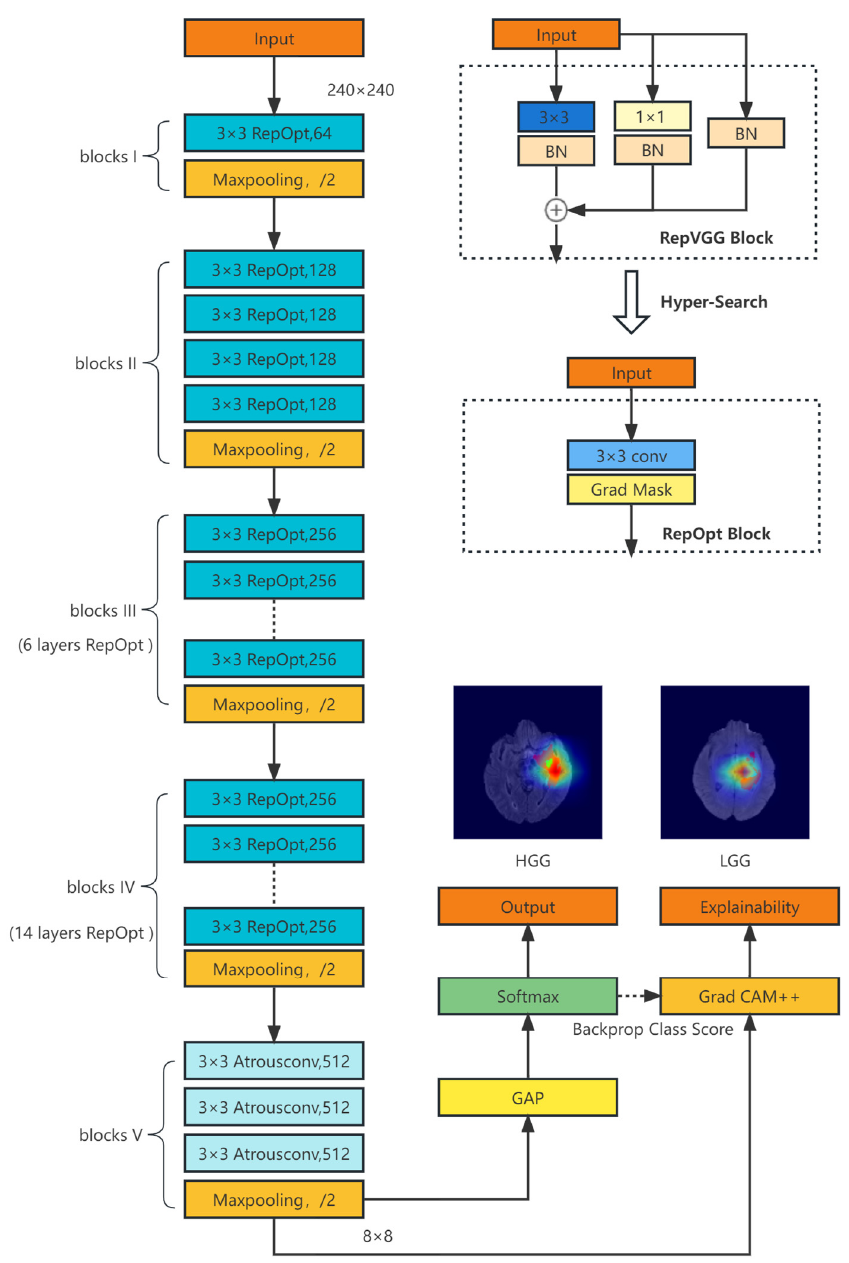
Figure 3. Classification network architecture.